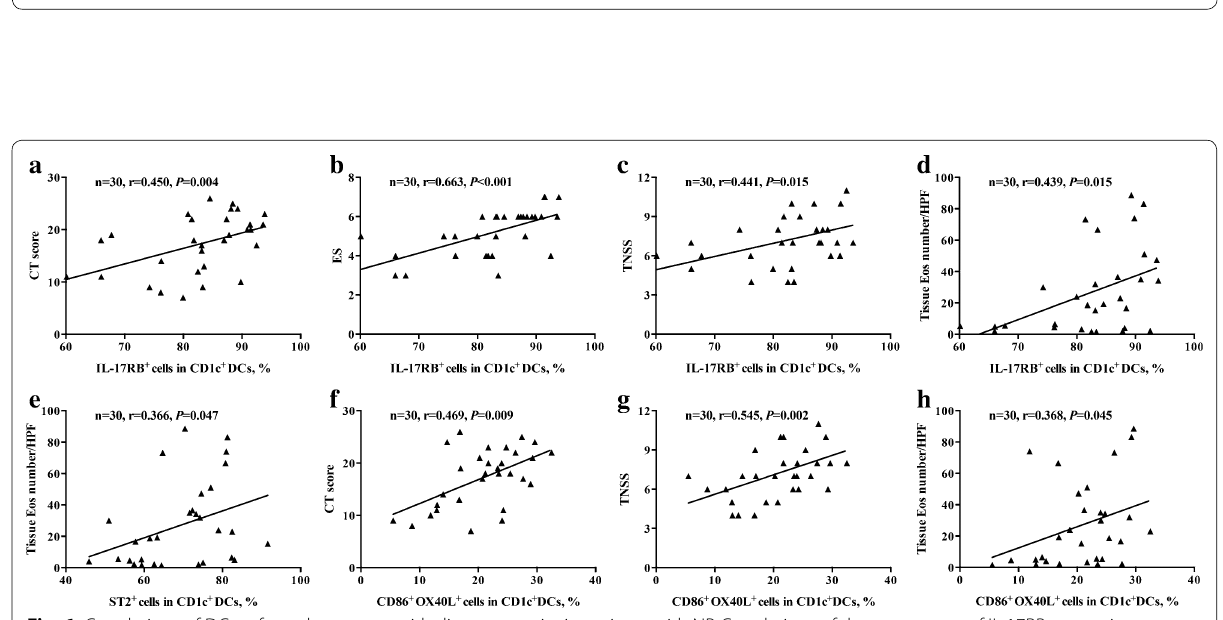
Fig. 6 Correlations of DC surface phenotypes with disease severity in patients with NP. Correlations of the percentage of IL‑17RB expression on CD1c + DCs in NP tissues with CT scores ( a ), endoscopic scores ( b ), TNSS ( c ) and mean tissue eosinophil count ( d ). Correlation of the percentage of ST2 expression on CD1c + DCs in NP tissues with mean tissue eosinophil count ( e ). Correlations of the frequencies of CD86 + OX40L + cells in CD1c + DCs in NP tissues with CT scores ( f ), TNSS ( g ) and mean tissue eosinophil count ( h ). CT computed tomography, ES endoscopic score, TNSS total nasal symptom score, Eos eosinophil, HPF high‑power